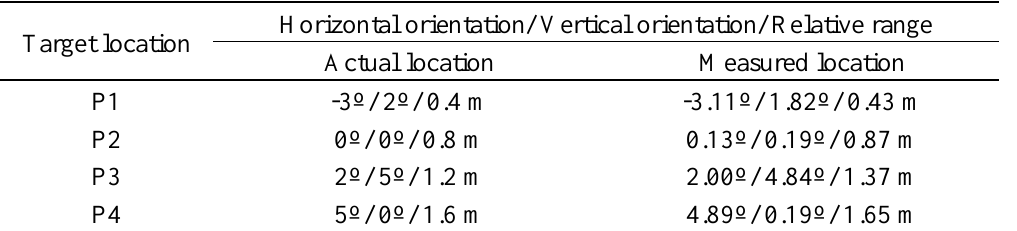
Table 1. Target location